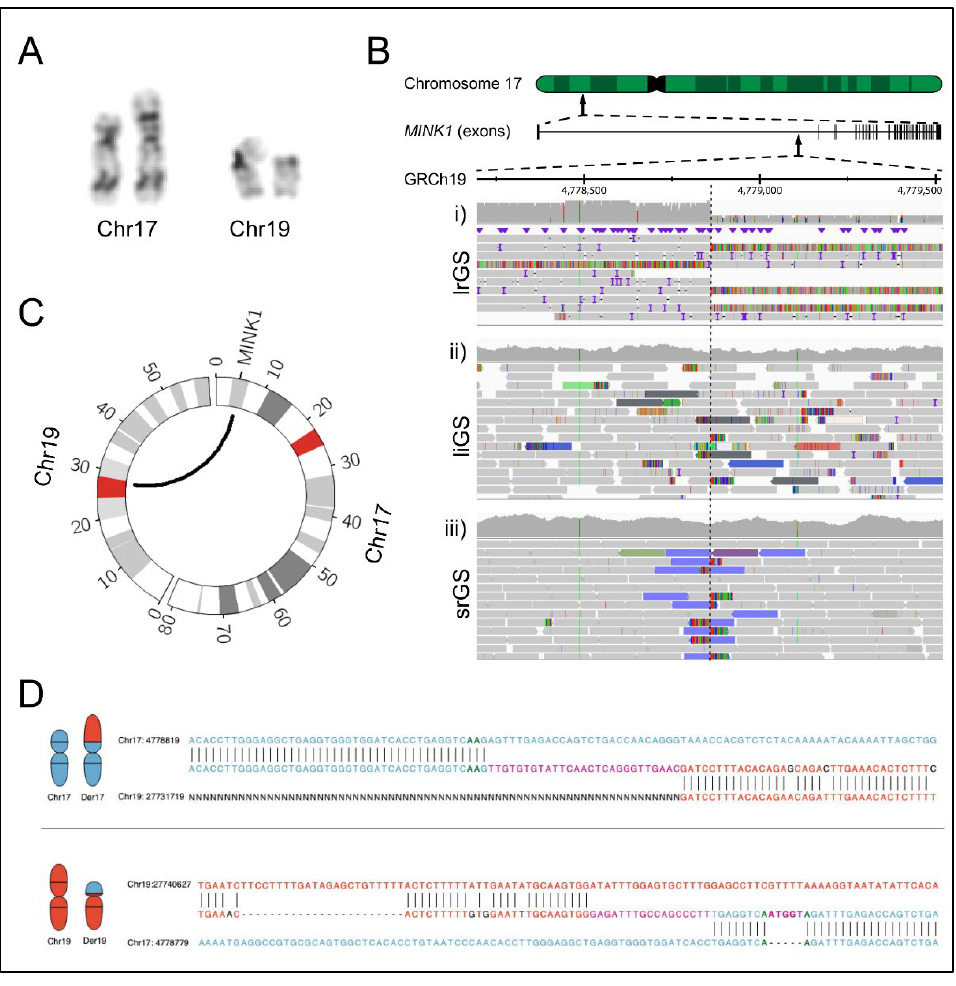
Figure 1. Genomic analyses of the t(17;19) translocation. ( A ) Excerpt of the patient karyogram, indi- cating a t(17:19) translocation. ( B ) View in the Integrative Genomics Viewer (IGV) of the translocation breakpoint in (i) Oxford Nanopore GS data (lrGS), (ii) 10X Chromium GS data (liGS), (iii) Illumina PCR-free GS data (srGS). ( C ) A circos plot illustrating the exact breakpoints of the translocations. ( D ) The upper pane illustrates the breakpoint junction sequence of Der (17), while the lower pane illustrates the sequence of Der (19). The reference sequences are shown as the lower and upper sequences in each pane, while the junction sequence is shown between. Horizontal lines indicate a match, purple sequence illustrates insertion. The sequence of chr19 is in red, and the sequence of chromosome 17 in blue.